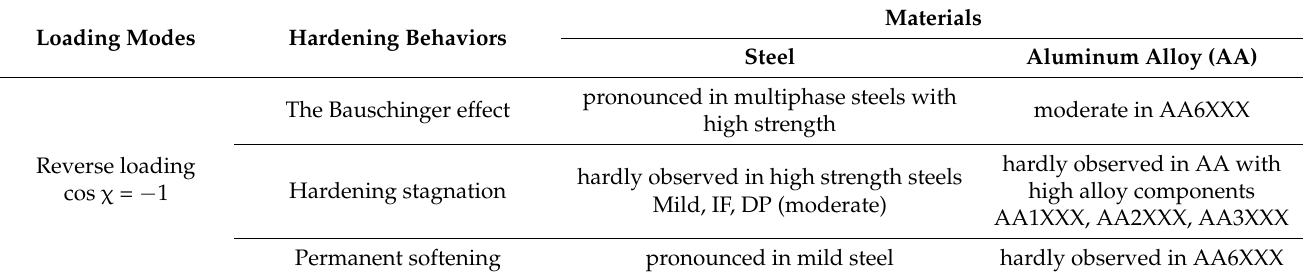
Table 1. Anisotropic hardening behaviors observed in typical steels and aluminum